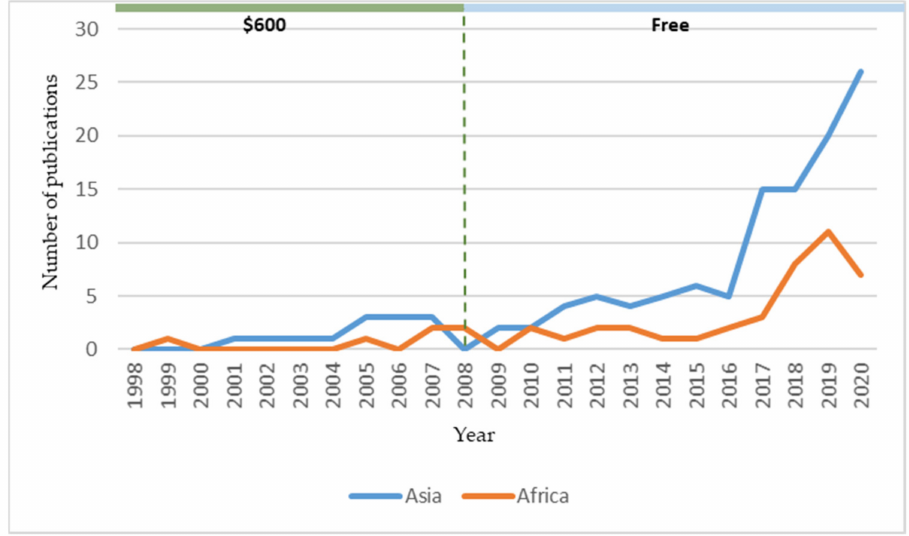
Figure 5. Number of annual publications in the selected Africa and Asian countries from 1998 to 2020 found in the Scopus database with the “Landsat” keyword in their title, abstract, or